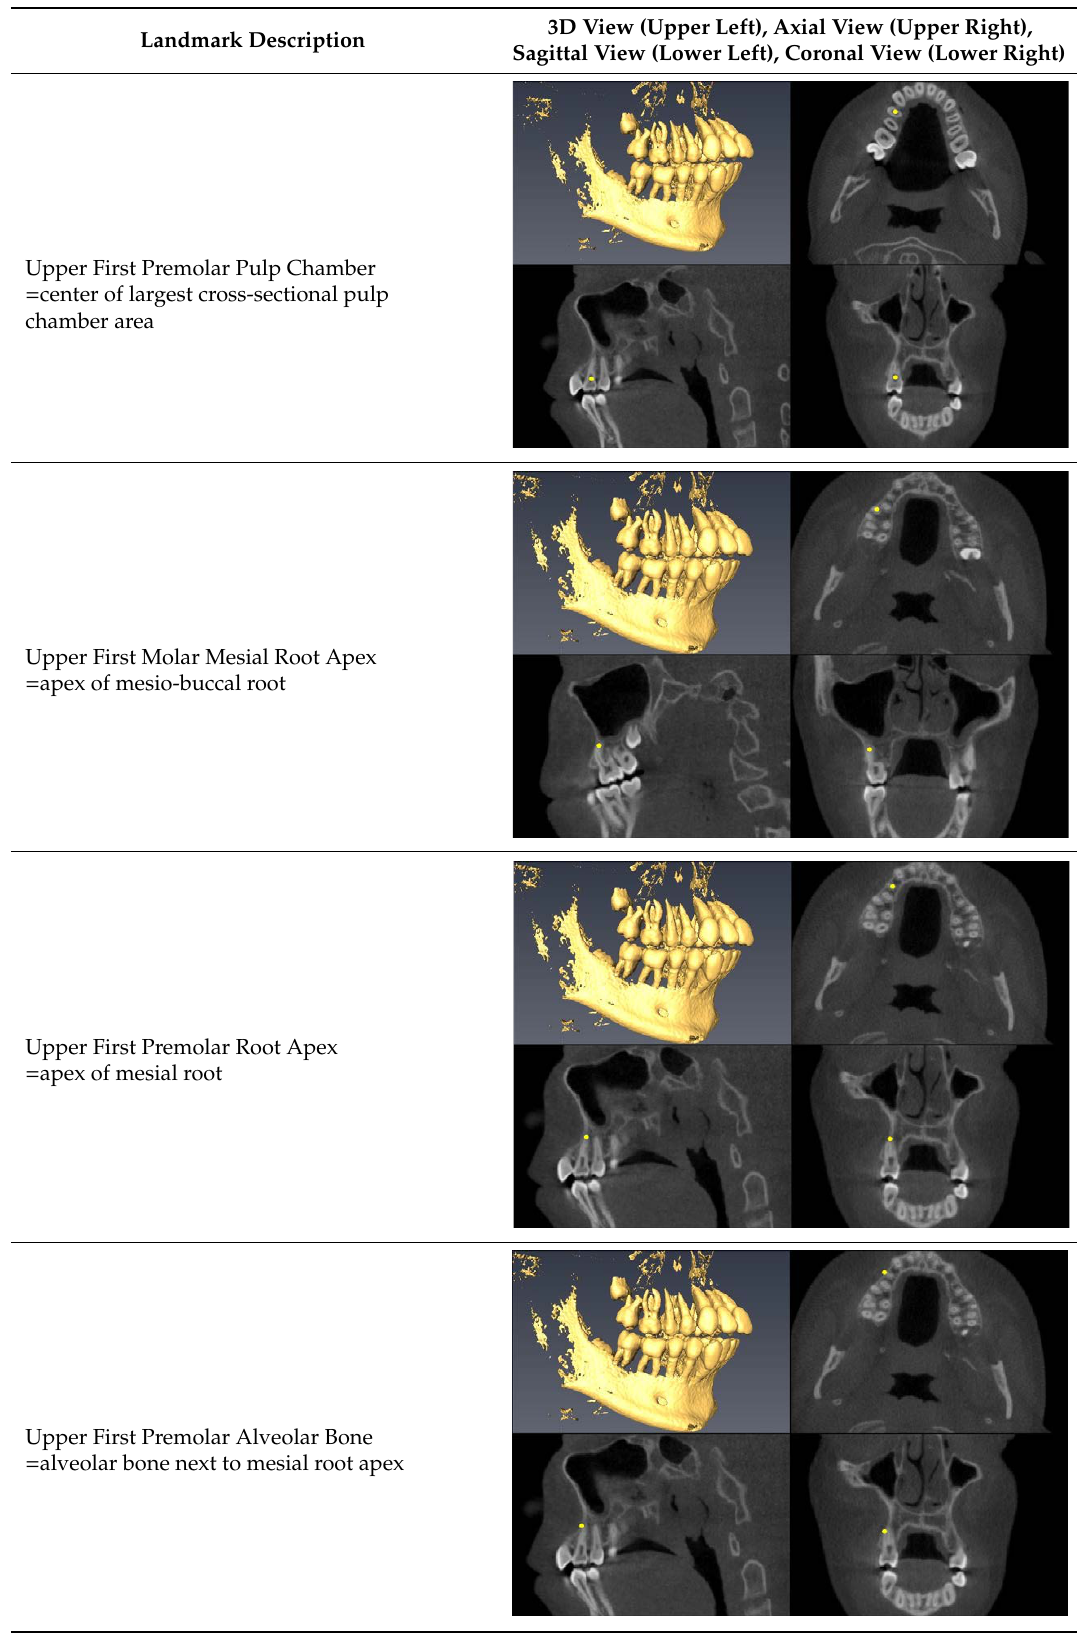
Table 3. Cont. 3D View (Upper Left), Axial View (Upper Right), Landmark Description Sagittal View (Lower Left), Coronal View (Lower Right)